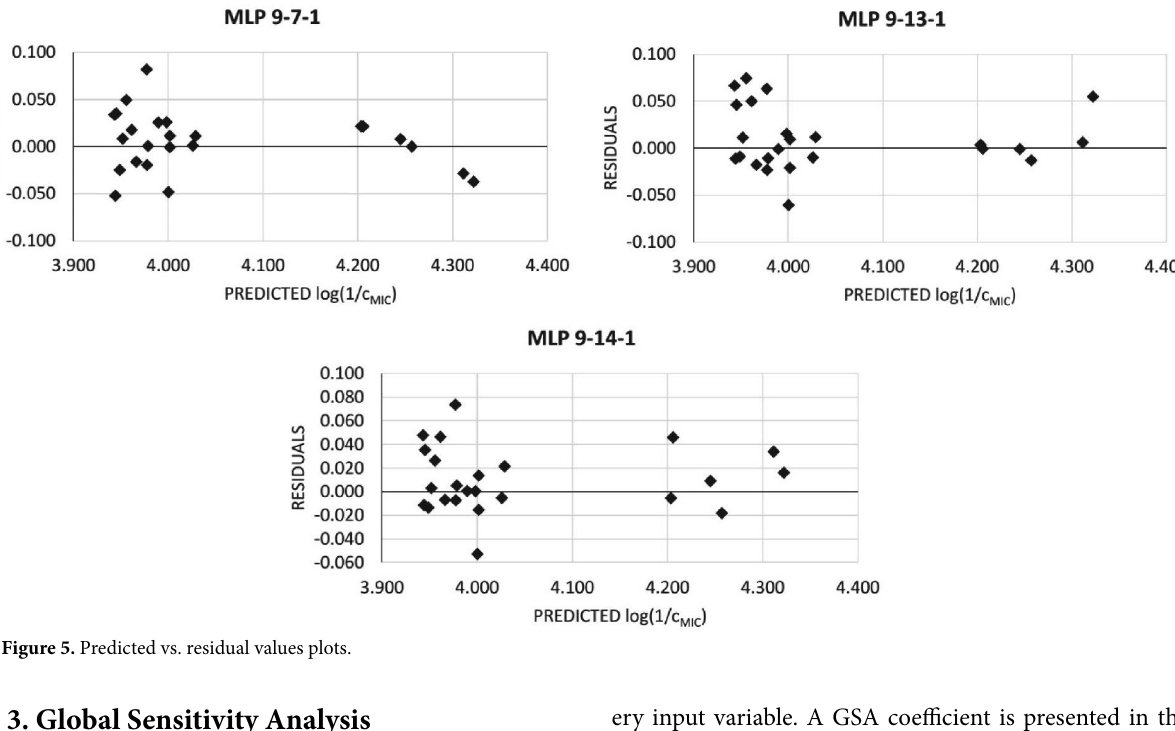
Figure 5. Predicted vs. residual values